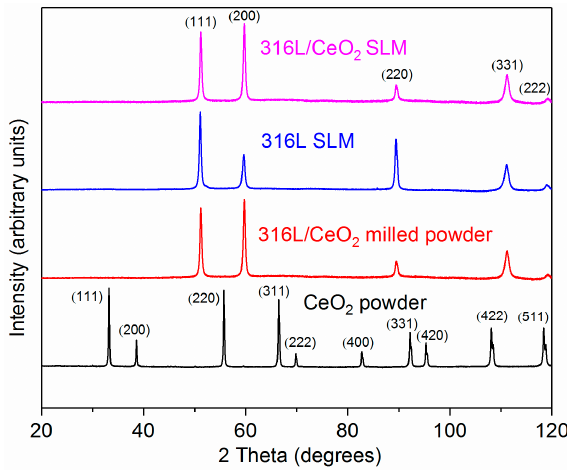
Figure 4. XRD patterns ( λ = 0.17889 nm) for pure CeO 2 powder, 316L/CeO 2 powder mixture ball milled for 2 h, an unreinforced 316L specimen processed at 688 mm/s, and a 316L/CeO 2 composite sample synthesized at 488 mm/s.